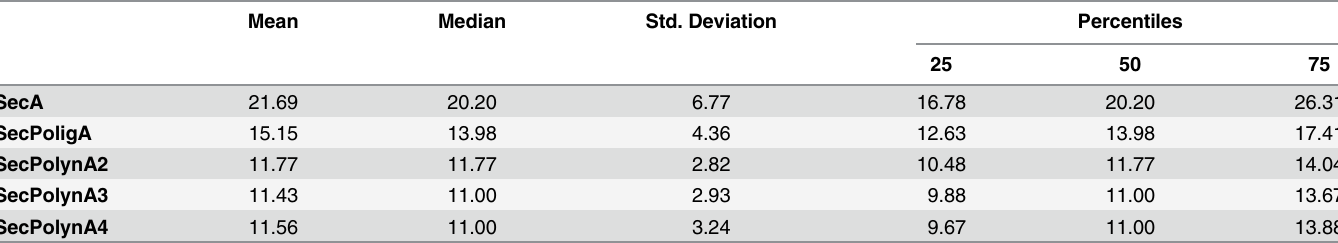
Table 3. Descriptive data for the NLC sectional area measurements.